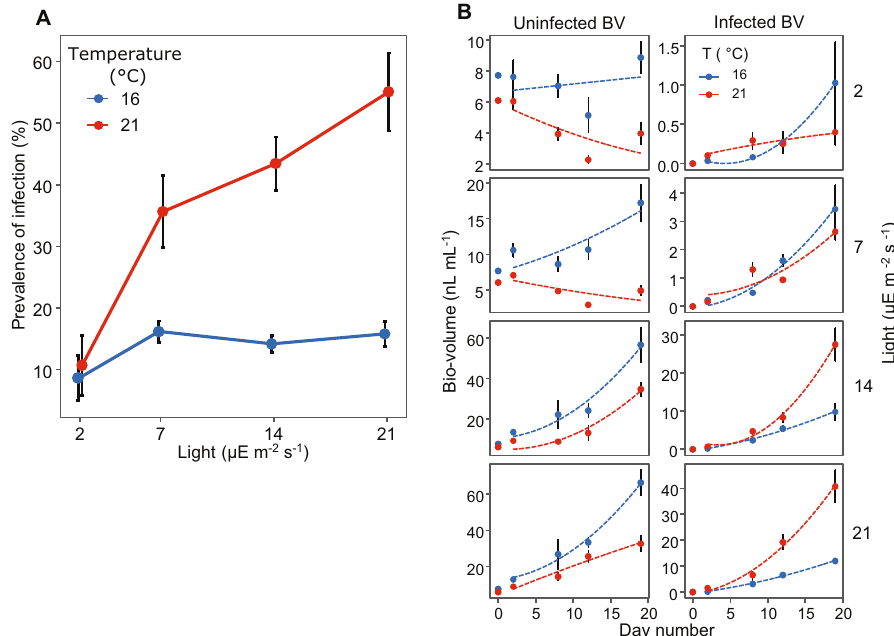
Fig. 2 P. rubescens is affected more strongly by the chytrid parasite at 21 °C, especially at high light. A Prevalence of infection as a function of light level on the last day of the experiment. The prevalence of infection increases with increasing light at 21 °C, but not at 16 °C. At 6 and 11 °C no infected fi laments were observed, and lines are not shown. B P. rubescens biovolume in the infected treatment, divided into uninfected and infected fractions; uninfected biovolume is shown in the left- and infected in the right-hand panels respectively.